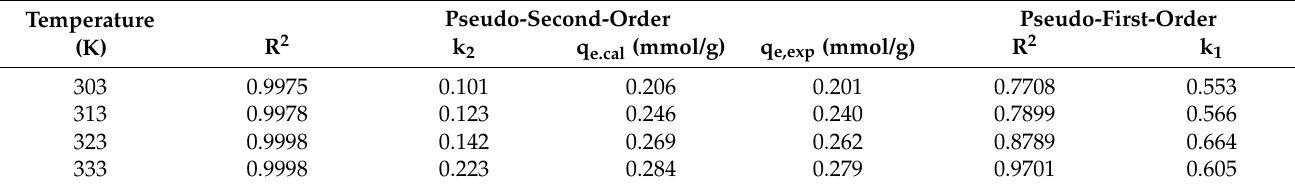
Table 2. Fitting parameters of the pseudo-first-order and pseudo-second-order